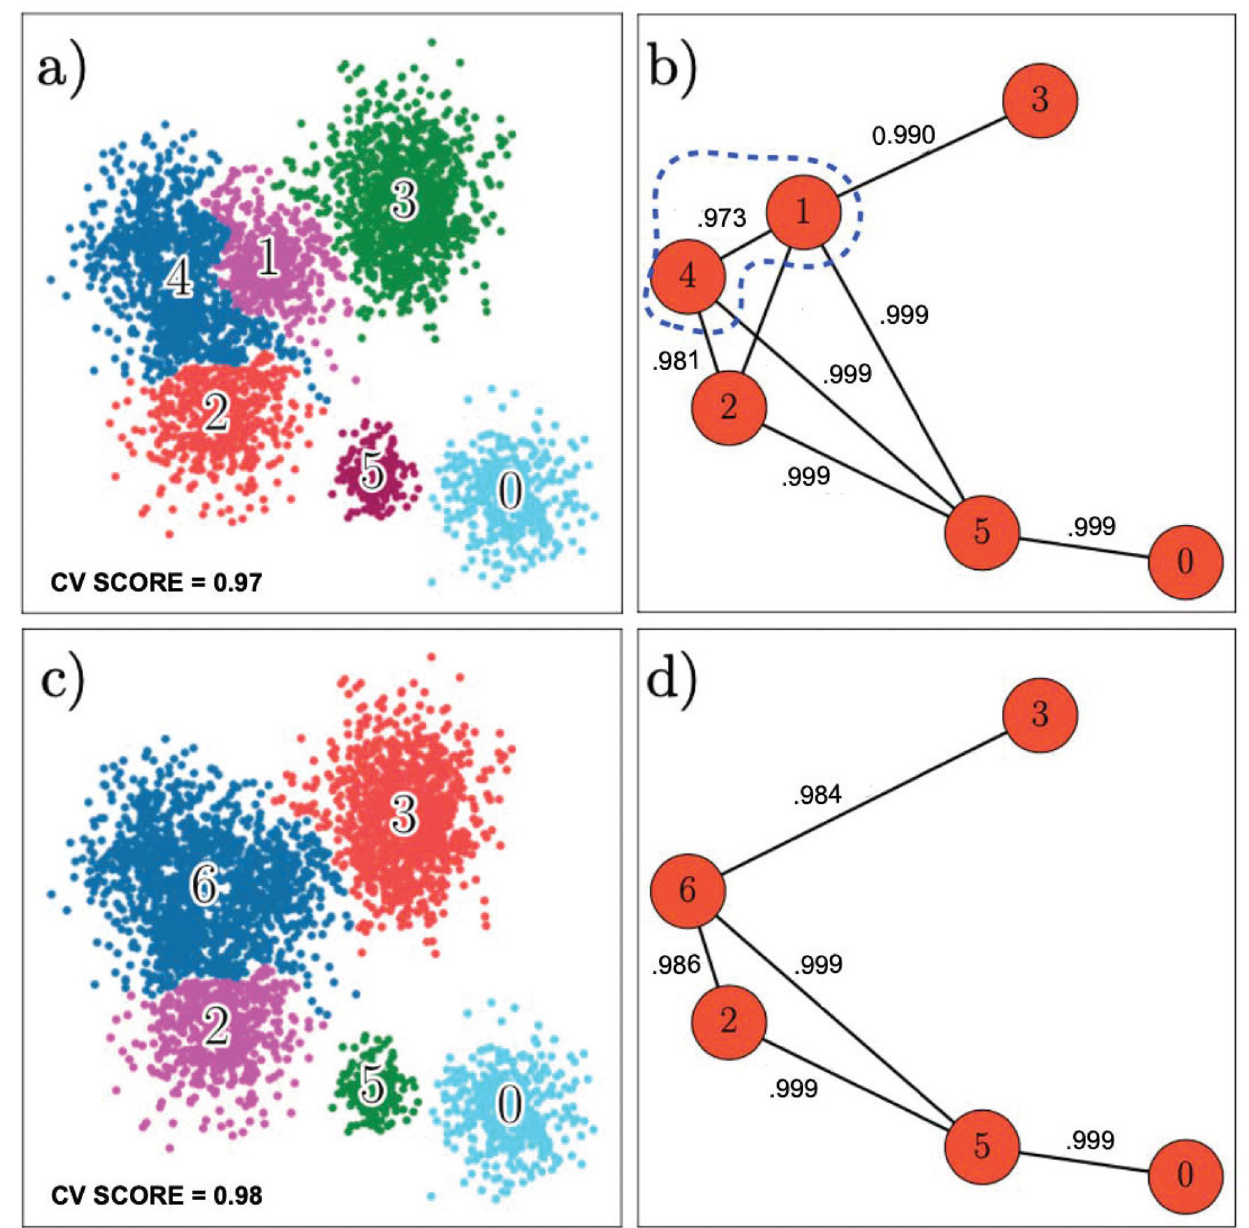
Fig 4. Clustering based on out-of-sample error. (a) Clusters generated with a cv-score of 0.97. (b) Graph illustrating out-of-sample error for each pair of clusters. There are no pairs of clusters with an out-of-sample error that is greater than 0.03 (accuracy value of 0.97). (c) Clusters generated with a cv-score of 0.98. Clusters 1 and 4 have been merged because the out-of-sample error was greater than 0.02. (d) Graph illustrating accuracy for each pair of clusters. There are no pairs of clusters with an out-of-sample error that is greater than 0.02 (accuracy value of 0.98).